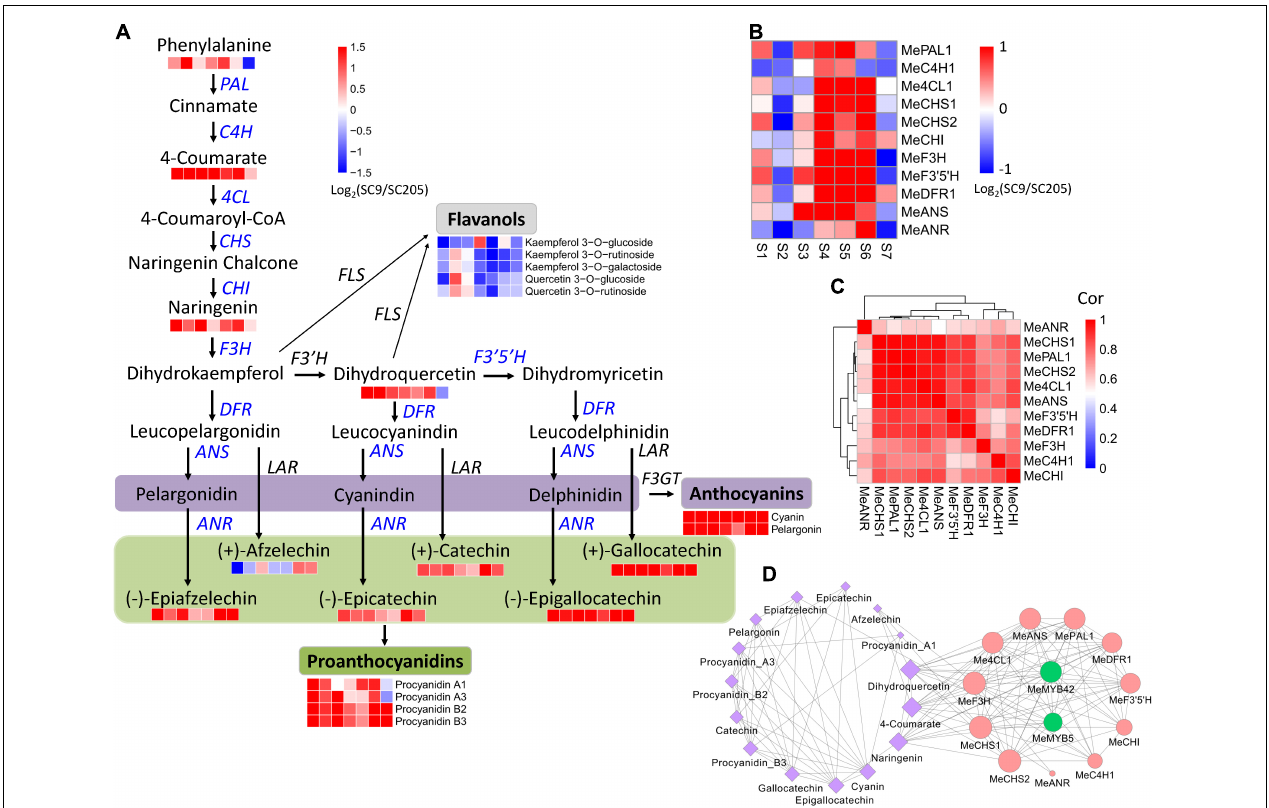
FIGURE 5 | Abundance changes of metabolites and genes relevant to anthocyanin biosynthesis during tuberous root development. (A) Summary of anthocyanin biosynthesis pathways. Heatmaps are shown where the metabolite levels changed significantly between SC9 and SC205 during tuberous root development. Co-expressed anthocyanin biosynthesis genes are indicated in blue. (B) Expression fold-change of co-expressed anthocyanin biosynthesis genes between SC9 and SC205 during tuberous root development. (C) Expression correlation of anthocyanin biosynthesis genes shown in panel (B) . (D) The network of co-expressed genes and metabolites relevant to anthocyanin biosynthesis. The edges were shown by setting the threshold = 0.65. Node size represents its connectivity to other genes/metabolites. Metabolites are colored by purple, while anthocyanin biosynthesis genes and transcription factors are colored by red and green,